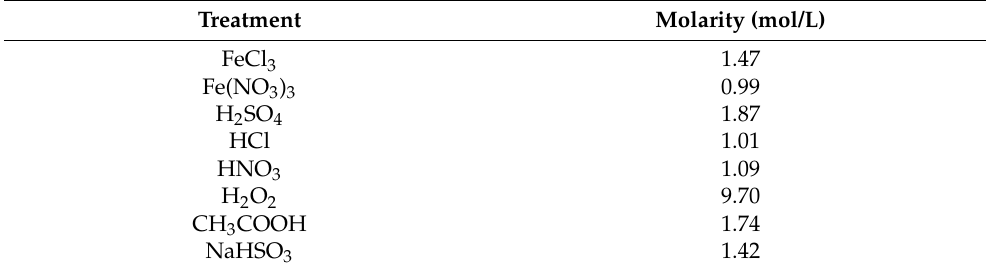
Table 2. Chemical treatments selected from interviews to obtain accelerated patinas on WS.